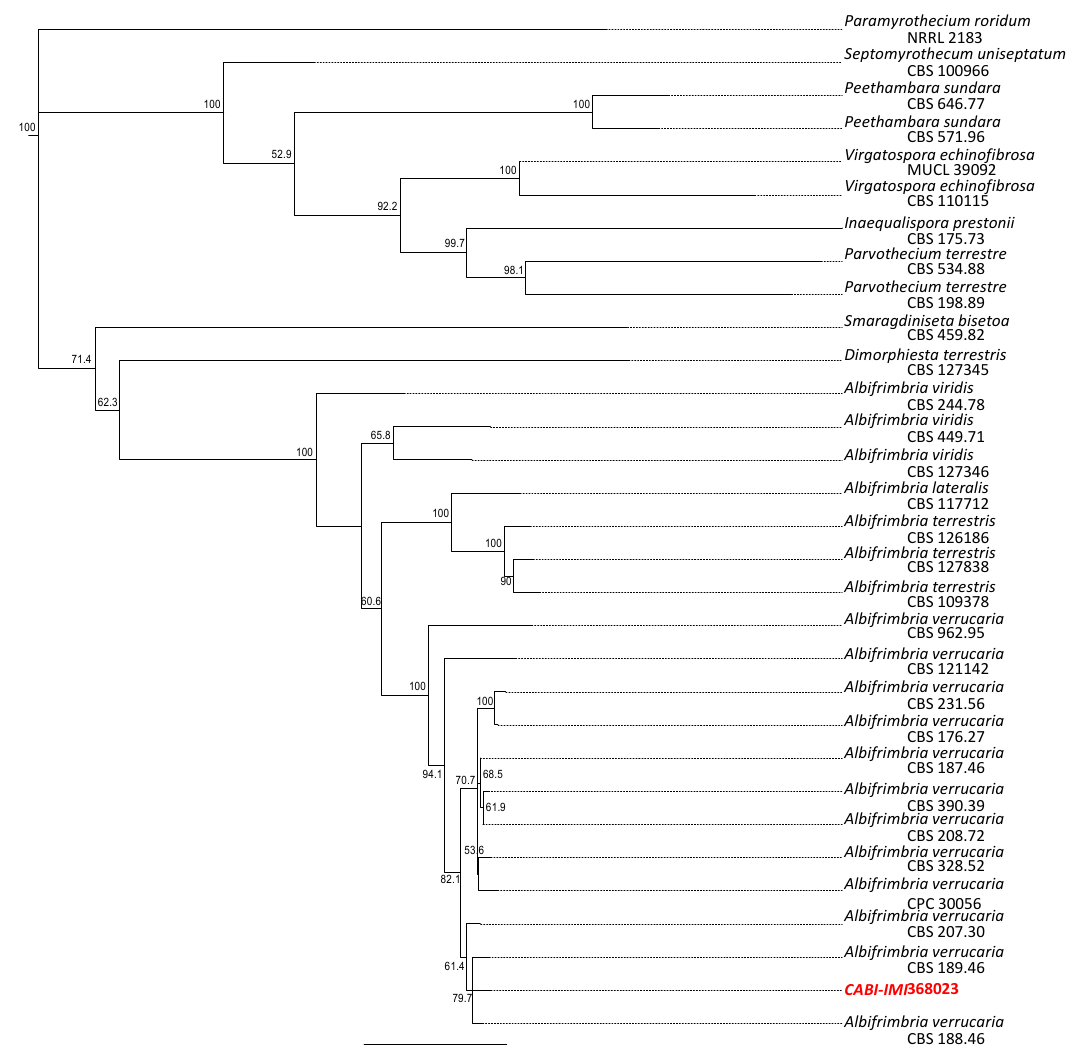
Figure 2. Consensus six-gene concatenated neighbor-joining tree placing the bioherbicidal isolate IMI 368,023 (highlighted in red) within Albifimbria verrucaria .